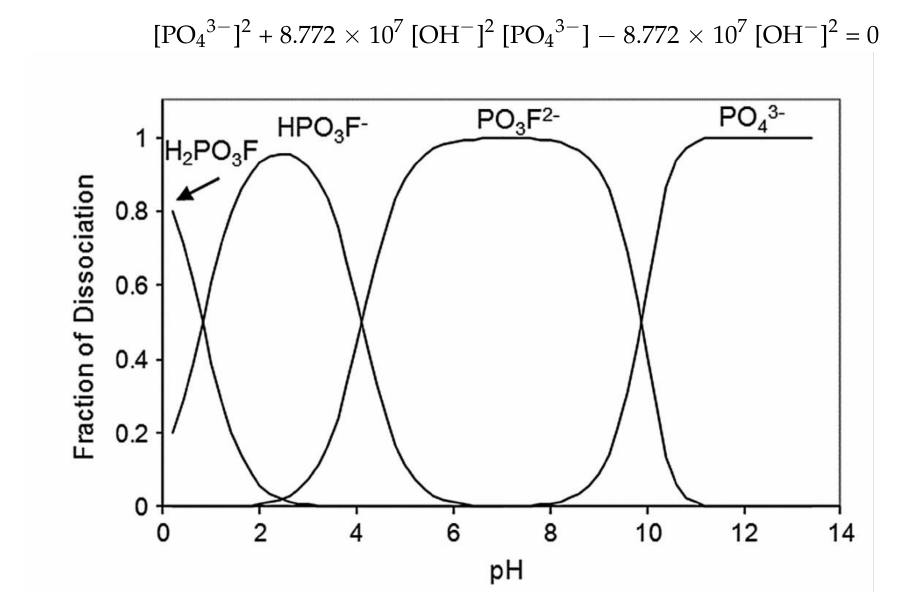
Figure 26. Distribution diagram for sodium monofluorophosphate (Na 2 PO 3 F) (MFP) [43]. Repro- duced with permission from Bastidas, D.M. et al., Cem. Conc. Comp.; published by Elsevier,